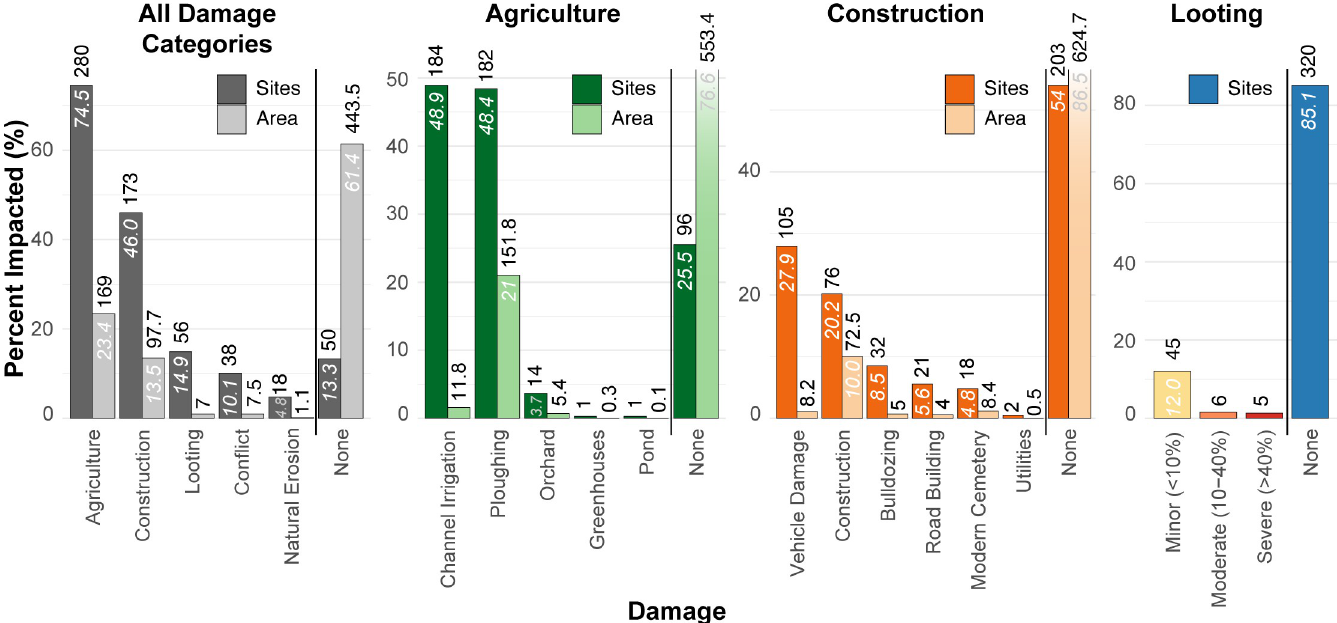
Fig 4. Graphs showing the percentages of sites and site areas impacted by the major damage type categories (far left), the two most prevalent subcategories of damage, agriculture and construction (center), and looting (far right). The percentages of sites and site areas (y-axis, labelled in italics inside bars) were calculated by dividing the number of sites and site area affected by each damage type (above bars) by the total number of sites assessed (376 sites) and the total site area (722.4 ha). Each site can be affected by multiple types of damage and thus summed percentages in each category may be greater than 100%.